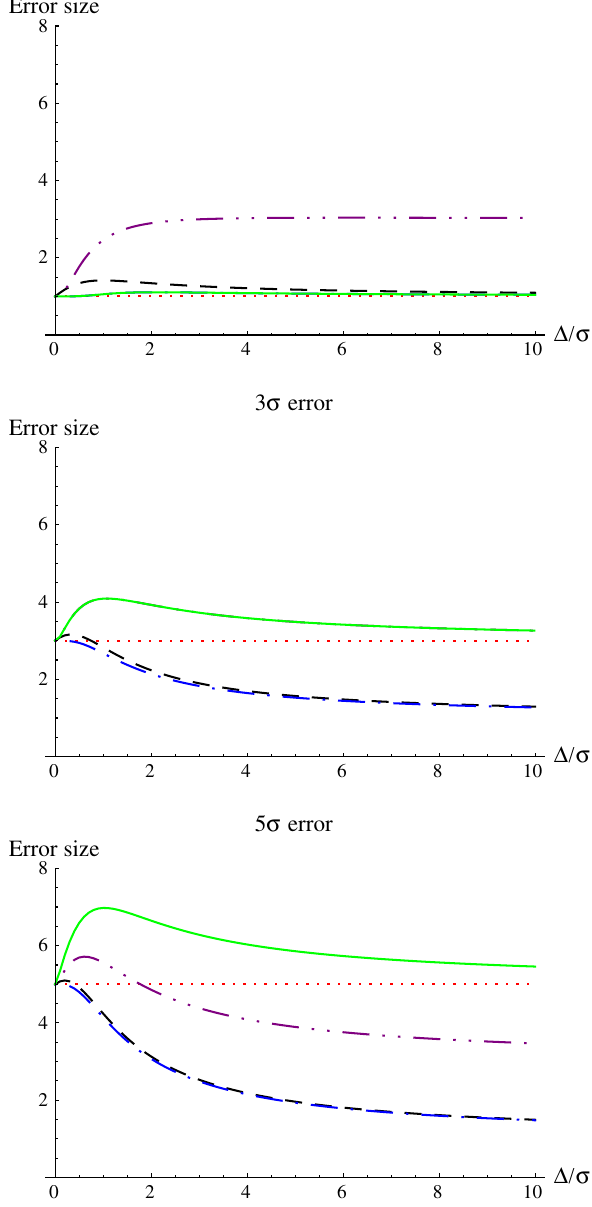
Fig. 5 Comparison of the size of the ( 1 , 3 , 5 )σ errors ( upper , cen- tral and lower panels , respectively) as a function of Δ/σ . Different approaches are shown: nG ( dotted , red ), Rfit or 1-external ( dashed , black ),fixed1-nuisance( dotted-dashed , blue ),fixed3-nuisance( dotted- dotted-dashed , purple ), adaptive nuisance ( solid , green ). In the upper panel (1 σ confidence level), the adaptive and fixed 1-nuisance approaches yield the same result by construction, and the two curves cannot be distinguished (only the adaptive one is shown). The same sit- uationoccursinthe centralpanel corresponding to3 σ withtheadaptive and fixed 3-nuisance approaches